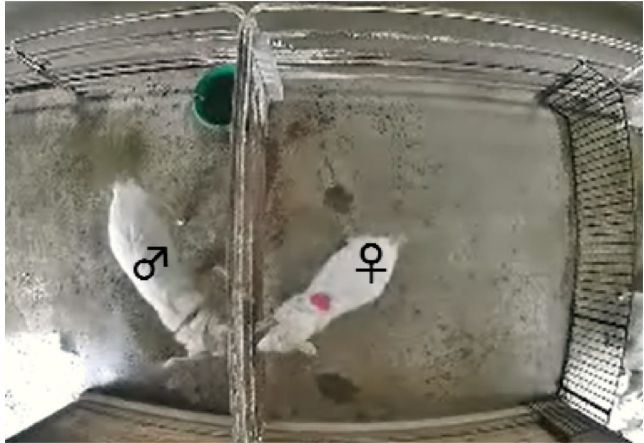
Figure 1. Image from the video recording data. One side of the observation pen was adjacent to the male paddock. A marker was attached to the back of the female goat to track its